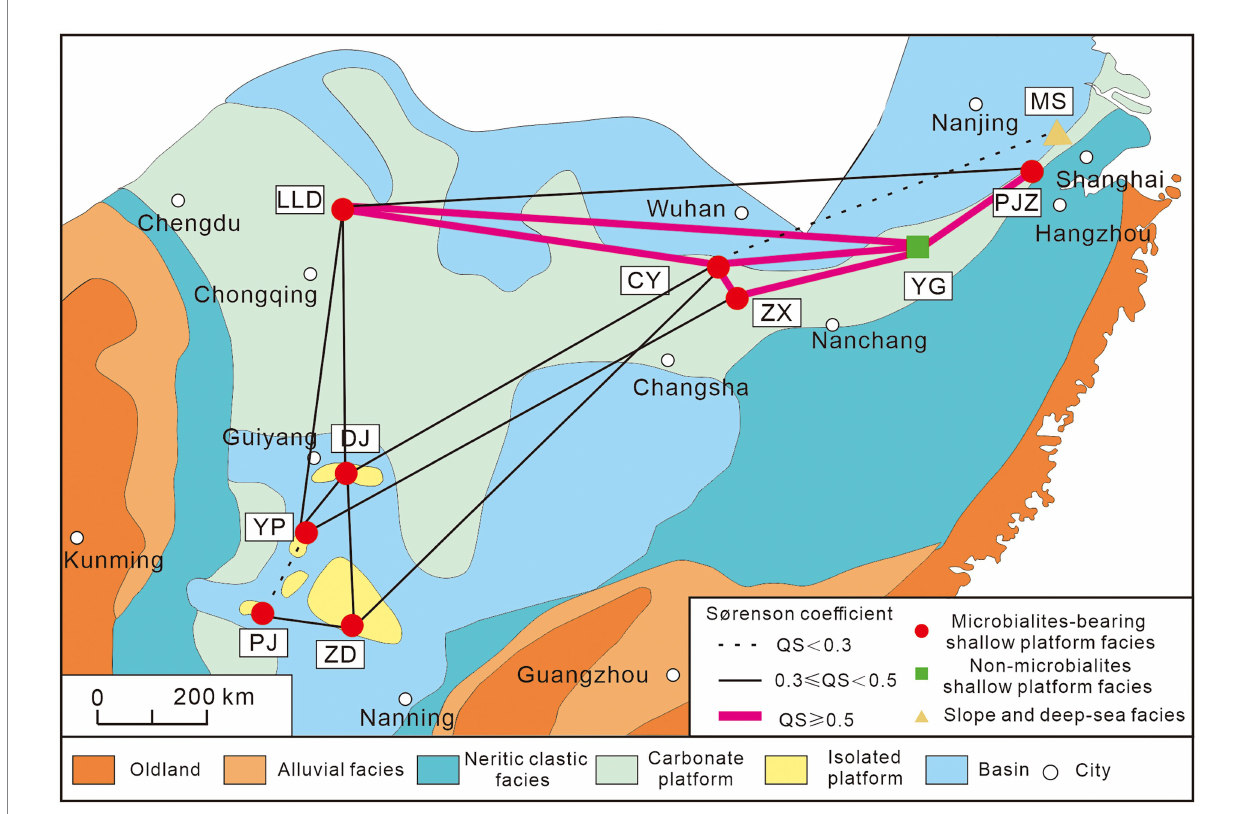
FIGURE 9 Similarities of ostracod fauna among different sections during the Permian–Triassic transitional beds. Paleogeography map of the South China modified after Yin et al. (2014). YP Youping section; ZD Zuodeng section; DJ Dajiang section; PJ Pojue section; LLD Laolongdong section;